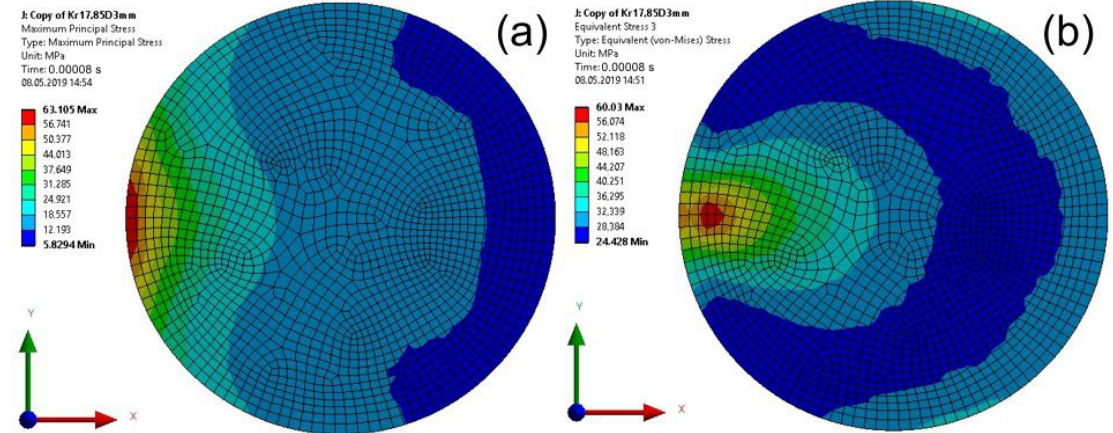
Figure 14. Map of the Main Principal Stress at the impact edge ( a ), and the von Mises Stress ( b ) removed from the impact edge in the joint for a computation time equal to 0.00008 s—Model no. 2 (linear analysis). The loads are applied in the direction of the X axis.